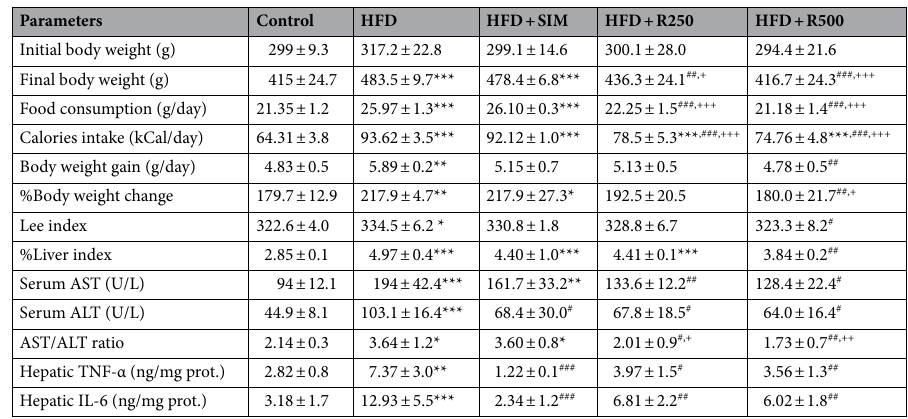
Table 1. Effect of roselle extract on animal and biochemical parameters. The data are presented as the mean ± SD values (n = 5–7 per group). The statistical differences as indicated by one-way ANOVA followed by Tukey’s post hoc test. The mean differences were significant compared with the control group (* P < 0.05, ** P < 0.01, *** P < 0.001), HFD group ( # P < 0.05, ## P < 0.01, ### P < 0.001) and HFD + SIM group ( + P < 0.05, ++ P < 0.01, +++ P < 0.001).